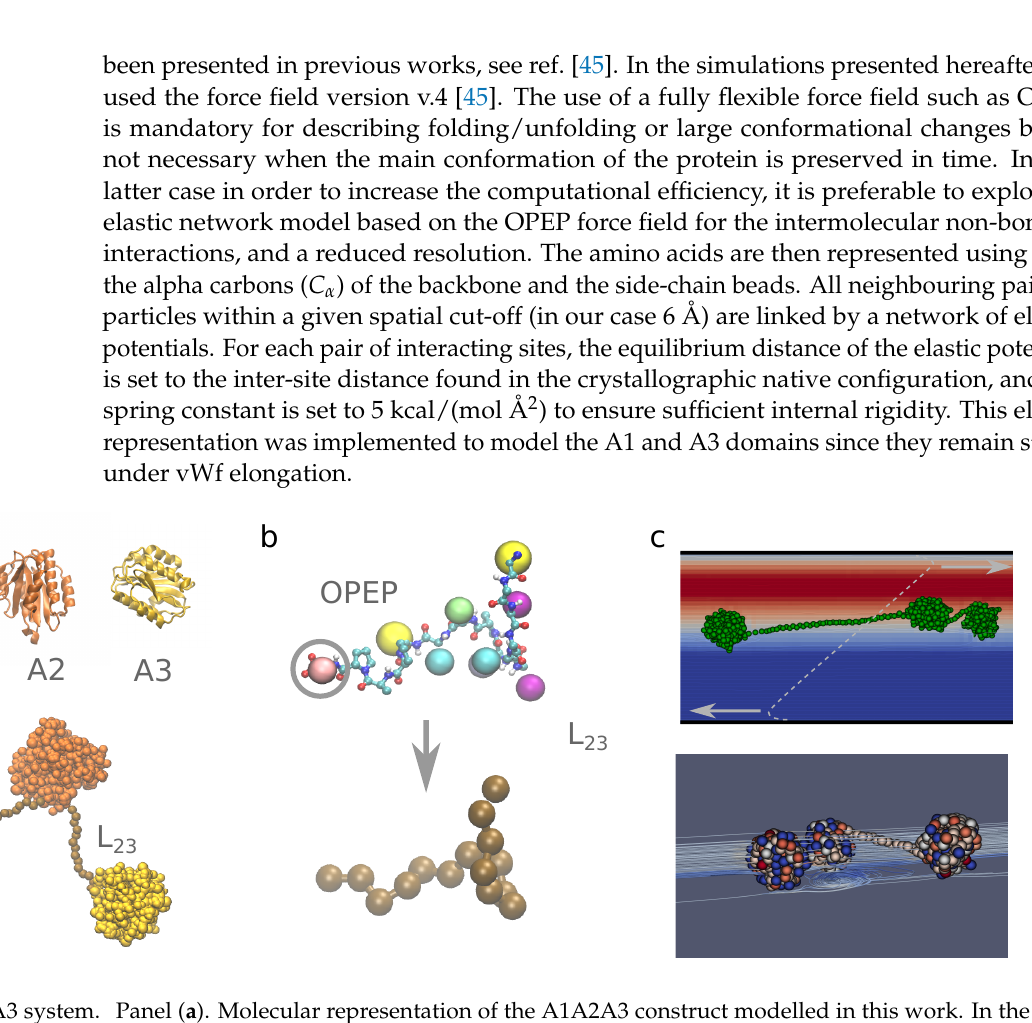
Figure 1. A1A2A3 system. Panel ( a ). Molecular representation of the A1A2A3 construct modelled in this work. In the top part we show the individual domains (from X-ray PDB structures) represented by their secondary structures. In the bottom part we show the A1A2A3 construct including the flexible amino acid sequences connecting the domains. Panel ( b ). The linker chain is represented using the OPEP ( top ) and a single bead ( bottom ) models for the amino acids. Panel ( c ). Representation of the Couette flow generated in the simulation box of the A1A2A3 system ( top ) with the velocity field represented by the colour gradient. In the ( bottom ) we highlight the local deformation of the velocity streamlines around the protein domains